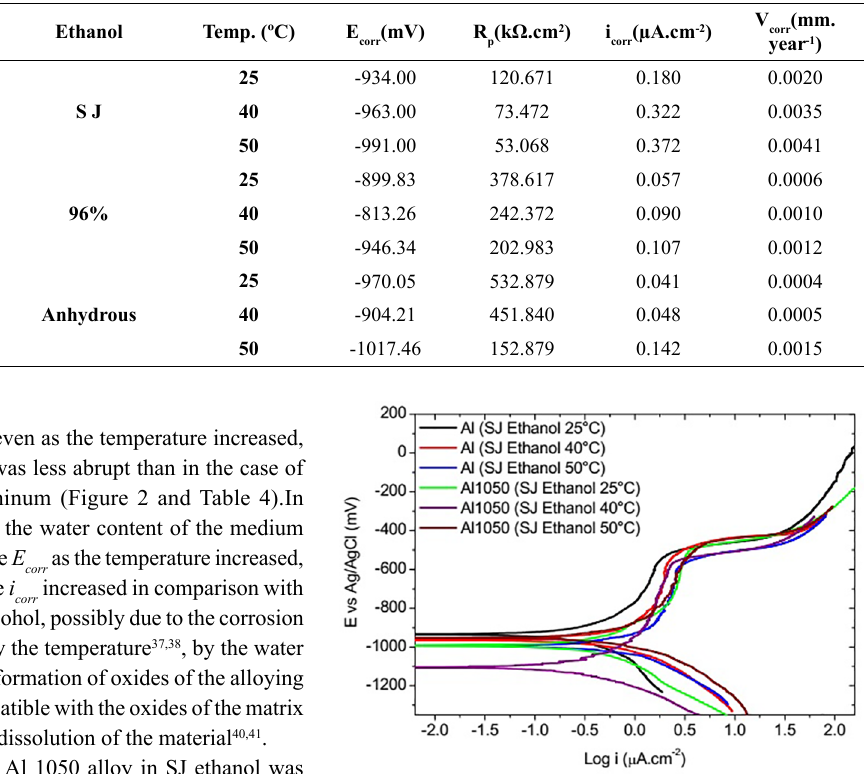
Figure 4. Potentiodynamic polarization curves for commercial grade aluminum (Al) and Al 1050 alloy in SJ ethanol at 25°C, 40°C and